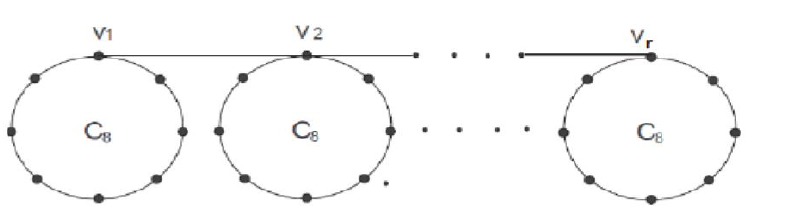
Figure 3. G r (C s , v ) over C s for Bridge Network. Table 3. Edge partition of G r (K s , v ) over K s .